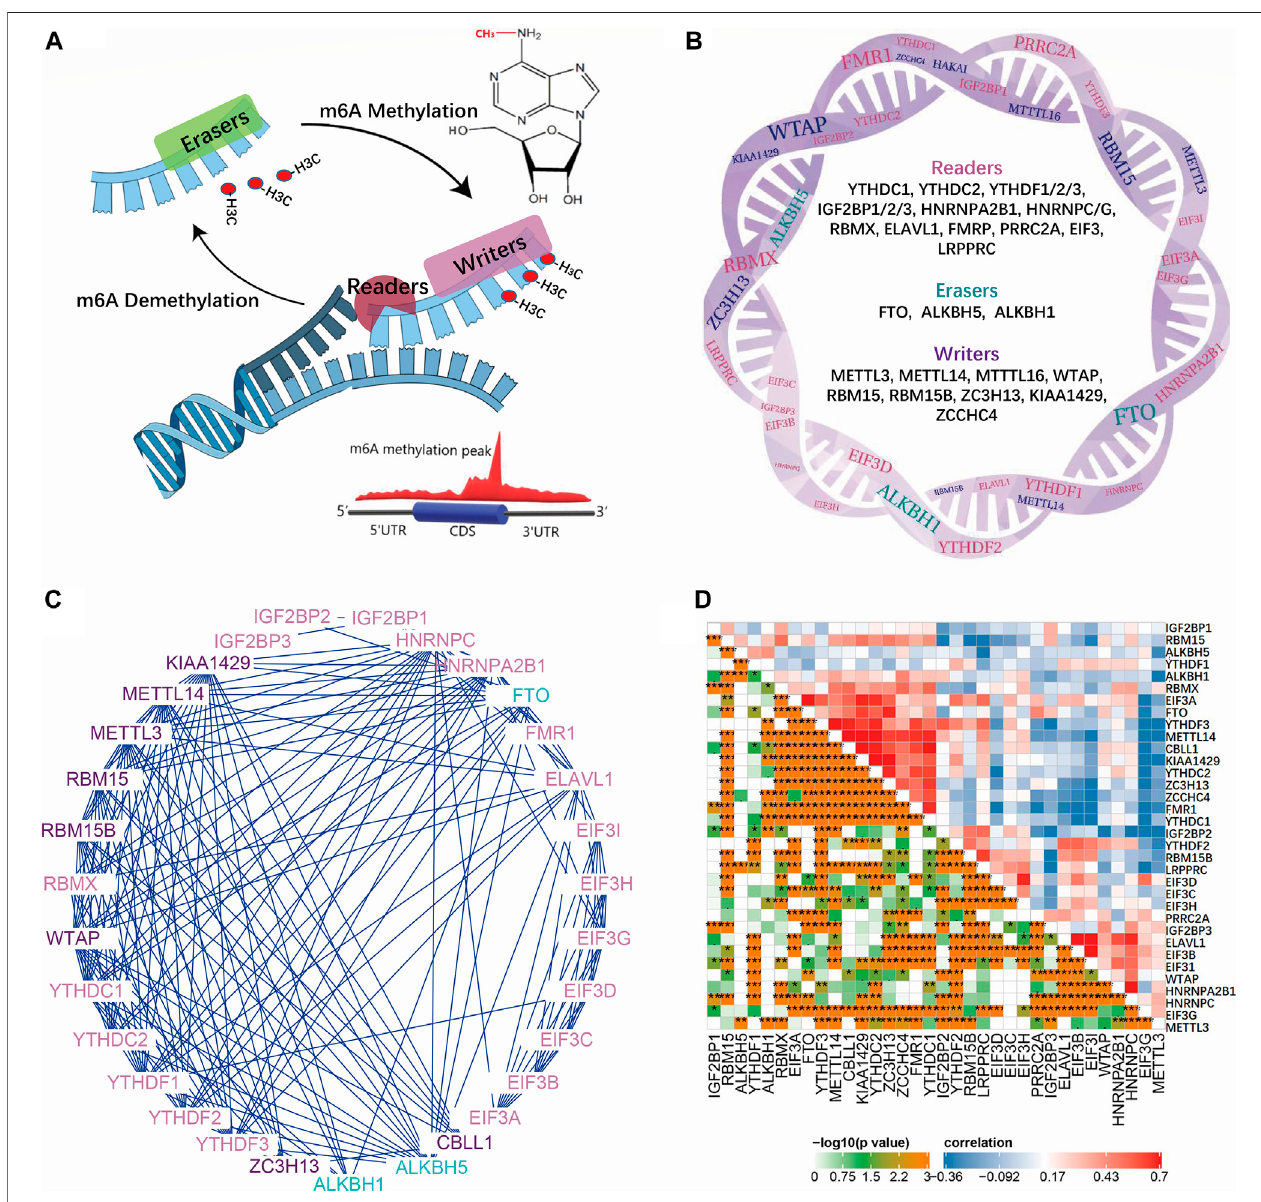
FIGURE 1 | Mechanism of m6A modi fi cations and the interaction of regulating genes. (A) is the reversible process of methylation on adenine which is modi fi ed by reader,writer and eraserproteins. (B) isthe detailed genelist ofreader,writer and eraserproteins. (C) istheinteraction networkofreader,writerand eraser proteins. (D) is the correlation map of m6A reader, writer and eraser proteins in IBDMDB cohort.